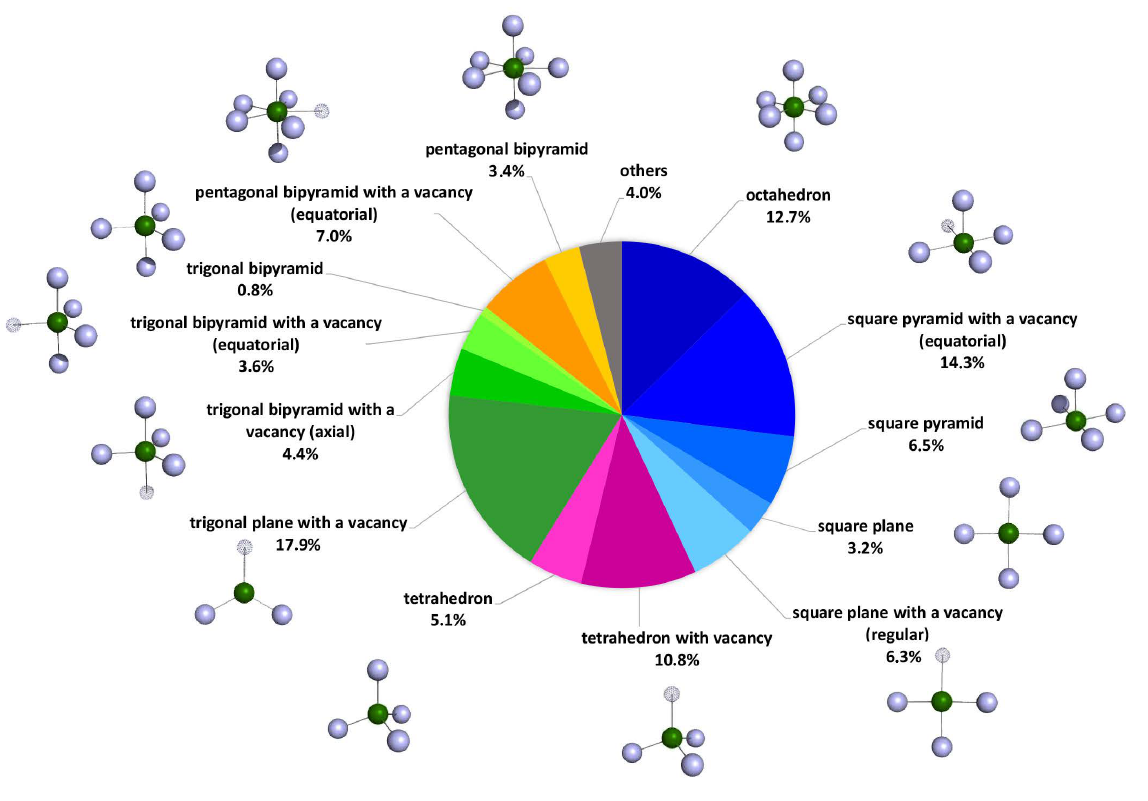
Figure 2. Percentage distribution of geometries for mononuclear Cd 2+ complexes in proteins, accord- ing to the Research Collaboratory for Structural Bioinformatics Protein Data Bank (RCSB PDB).